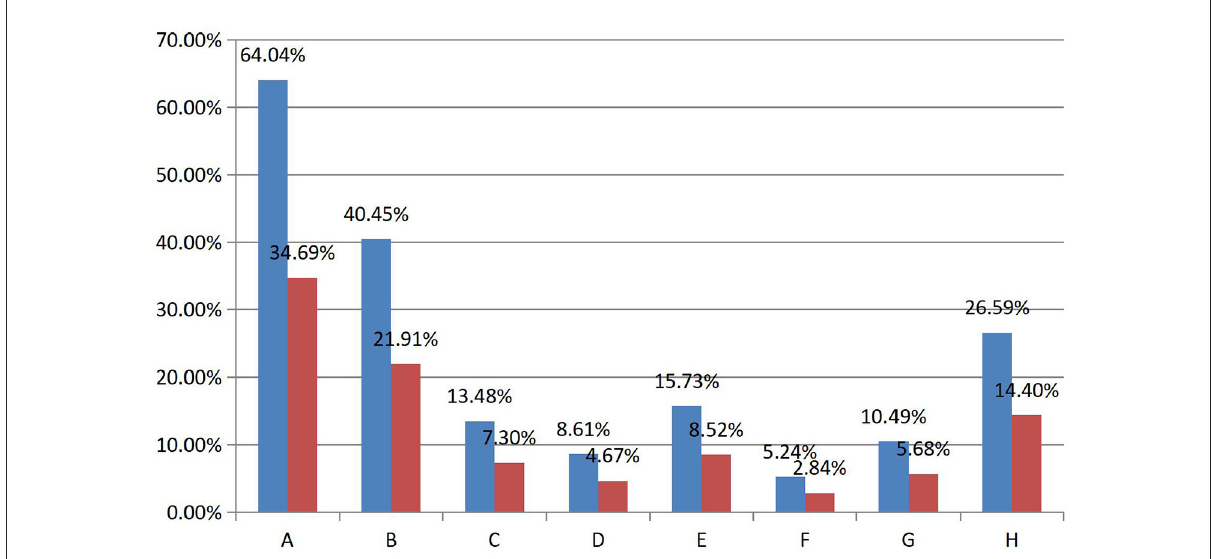
FIGURE1 Summary table of and prevalence rates. (A) Someone who is talented. (B) Someone who is authentic. (C) Someone who is sophisticated. (D) Someone who is distant. (E) Someone I admire. (F) Someone who understand me. (G) Someone who is the person I want to meet in person. (H)